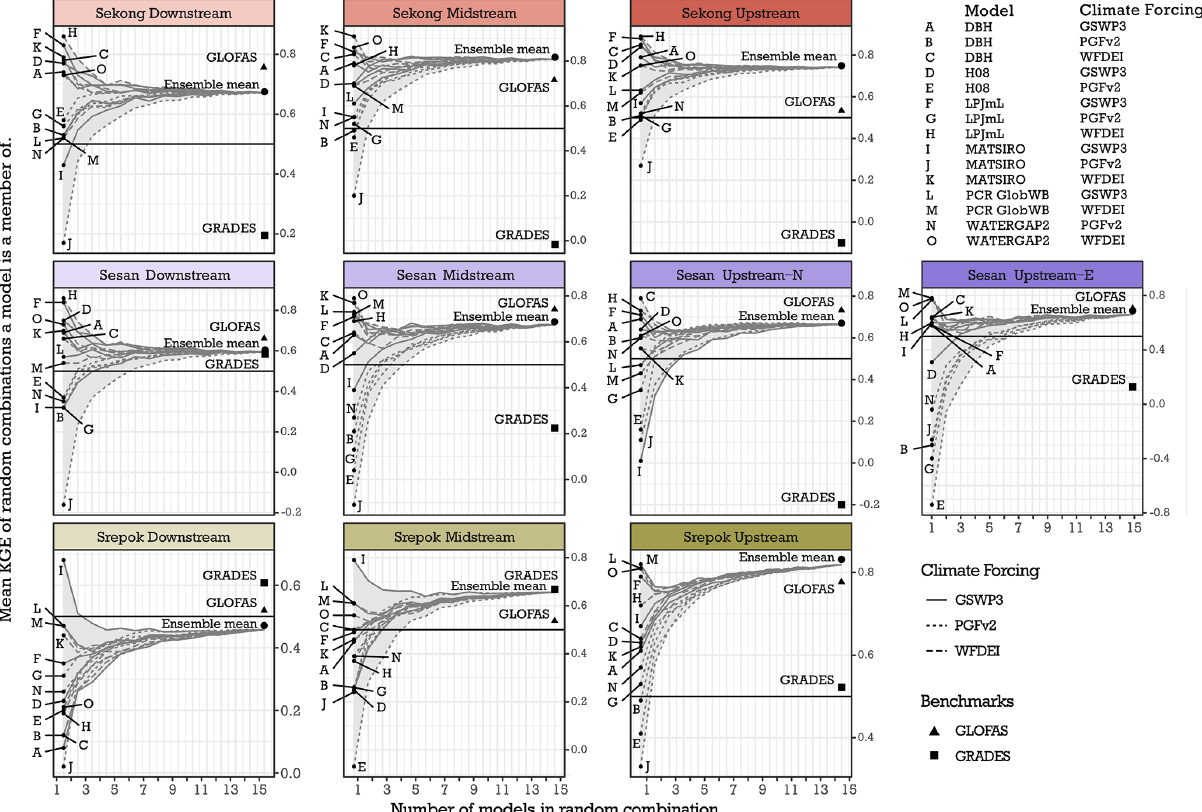
Figure 5. KGE performance of individual downscaled runoff ensemble members and the mean KGE of the random ensembles each model is a member of. The two benchmarks GRADES and GLOFAS and the ensemble mean are marked for